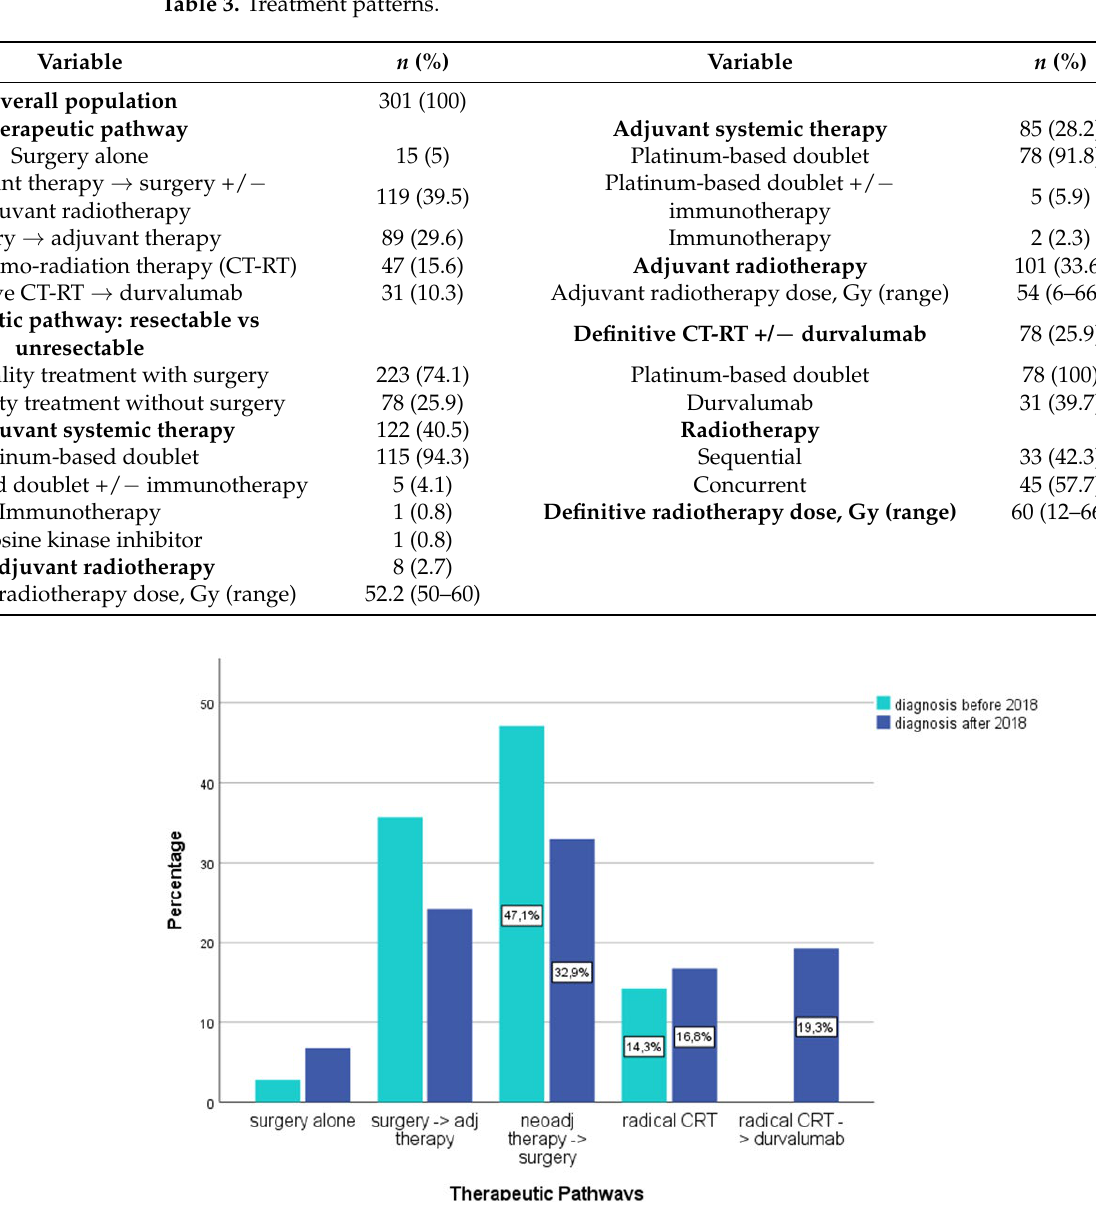
Figure 3. Bar graphs of timing of radiotherapy before and after 2018. CRT, chemo-radiation ther- apy; RT, radiotherapy. In the intention to treat (ITT) population, 122 patients underwent neoadjuvant ther- apy and the radiologic evaluation at the end of the induction treatment revealed the fol- lowing data: 65 patients (53.3%) had a partial response (PR), 1 (0.8%) had a complete ra- diological response (CR), 51 (41.8%) reached a stable disease (SD), and 4 (3.3%) had pro- gressive disease (PD). As regards the pathological response, the evaluation of tumour bed in surgical spec- imens of 70 patients who underwent neoadjuvant therapy has been made to assess the MPR and pCR. In our study population, 46 ADC, 19 SCC, 3 sarcomatoid carcinomas, 1